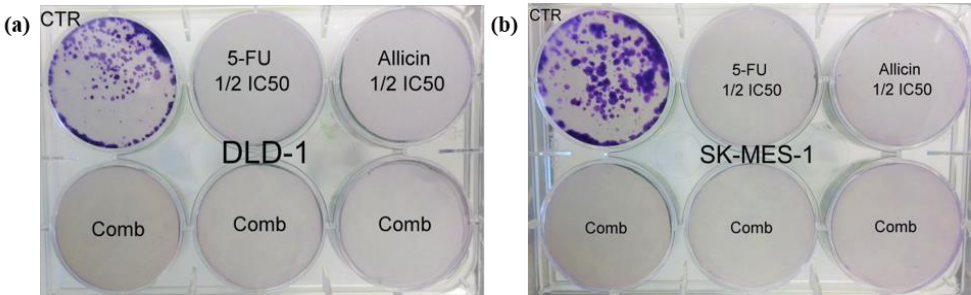
Figure 6. The investigation of the migration and colony formation capacity after allicin, 5-FU, and co-treatment. The DLD-1 ( a ) and SK-MES-1 ( b ) colony formation was inhibited by single-agent treatments and co-treatment. Abbreviations: CTR, control group; 5-FU 1/2IC 50 , half of the 5-fluorouracil IC 50 -treated group; Allicin 1 / 2 IC 50 , half of the Allicin IC 50 -treated group; Comb, the co-treatment group. 2.4. The Evaluation of Apoptosis and Necrosis after Single-Agent Treatments and Co-Treatment